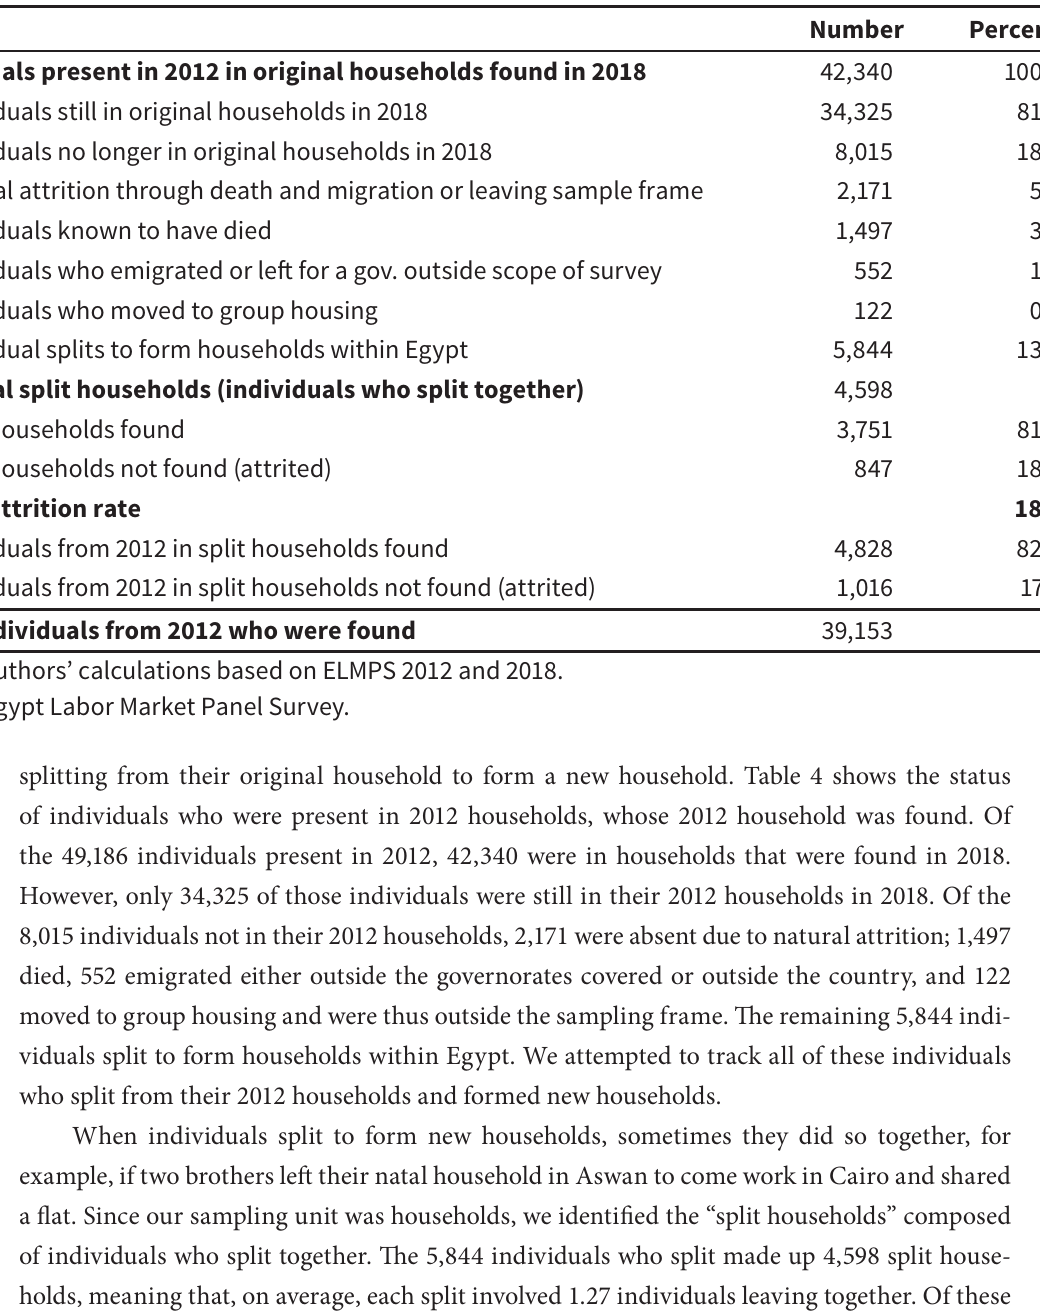
Status of individuals and split households in 2018, conditional on 2012 household being found Individuals present in 2012 in original households found in 2018 42,340 100.0 Individuals still in original households in 2018 Individuals no longer in original households in 2018 Natural attrition through death and migration or leaving sample frame Individuals known to have died Individuals who emigrated or left for a gov. outside scope of survey Individuals who moved to group housing Individual splits to form households within Egypt Potential split households (individuals who split together) Split households found Split households not found (attrited) Individuals from 2012 in split households found Individuals from 2012 in split households not found (attrited) Total individuals from 2012 who were found